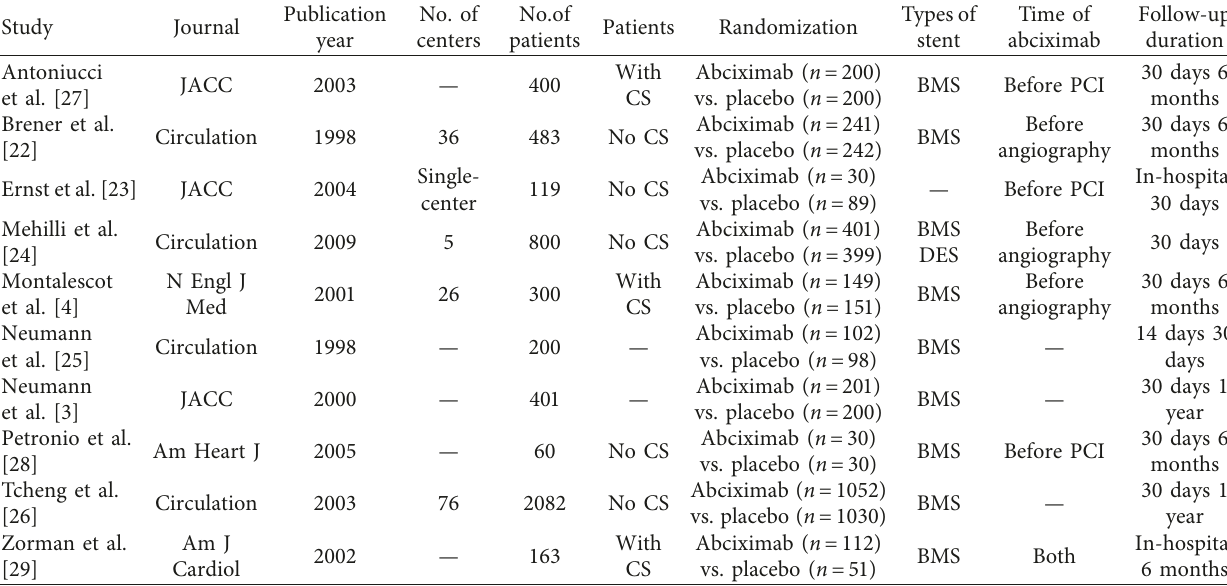
Figure 1: Flow diagram of literature search. Table 1: Characteristics of the trials